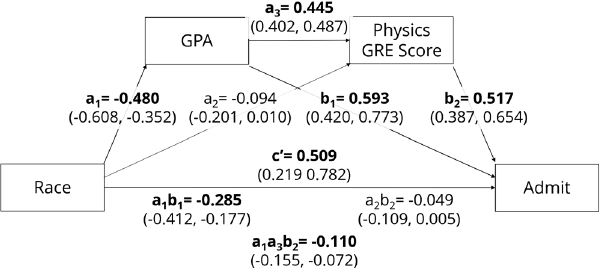
FIG. 13. Visual representation of the bootstrapped coefficients in Eqs. (5) to (7). We do find evidence of GPA mediating race and admission status and a serial mediation effect but do not find evidence of the physics GRE mediating race and admission status. Statistically significant coefficients are in